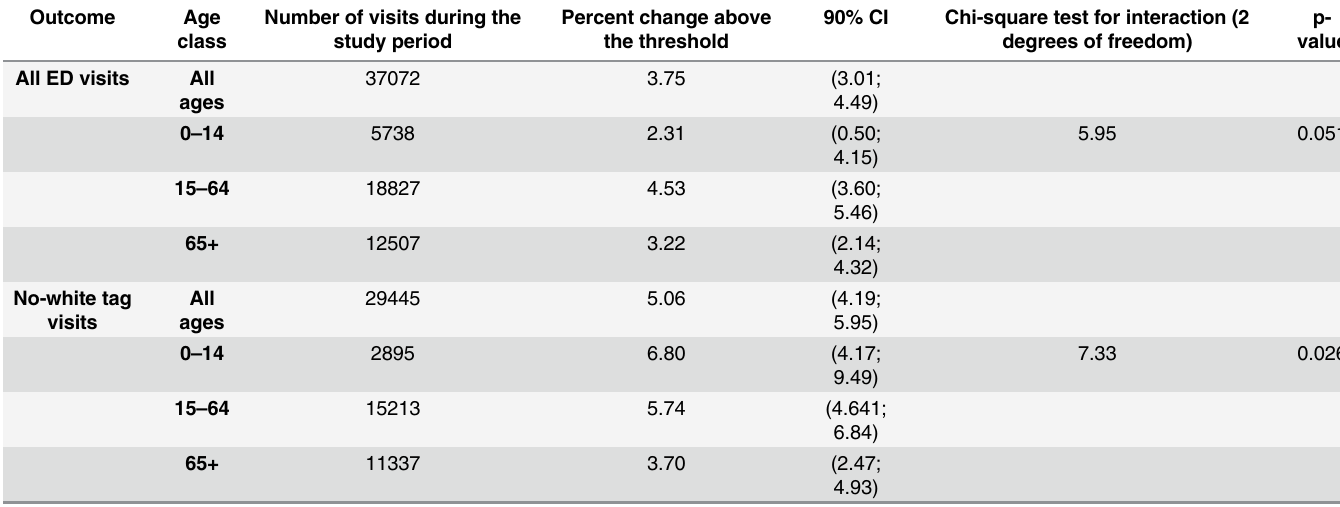
Table 1. Estimated effect of mean apparent temperature above the threshold on ED visits at lag 0 – 3.